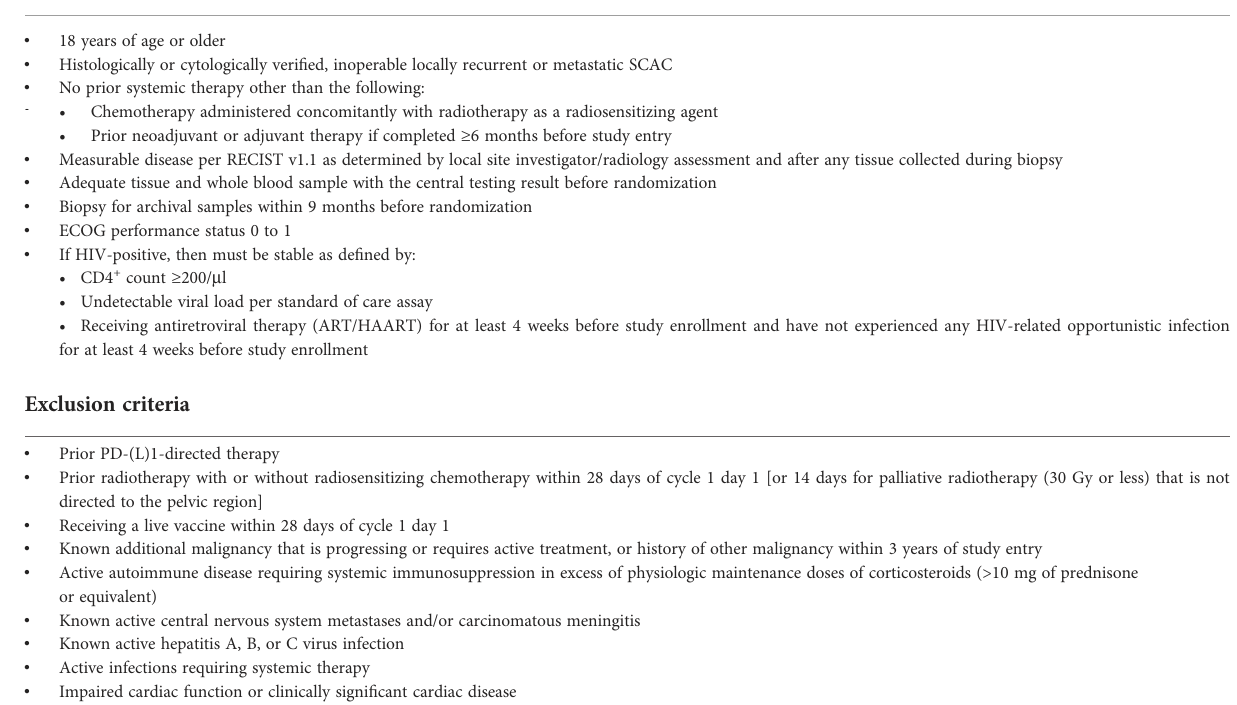
TABLE 1 Key inclusion and exclusion